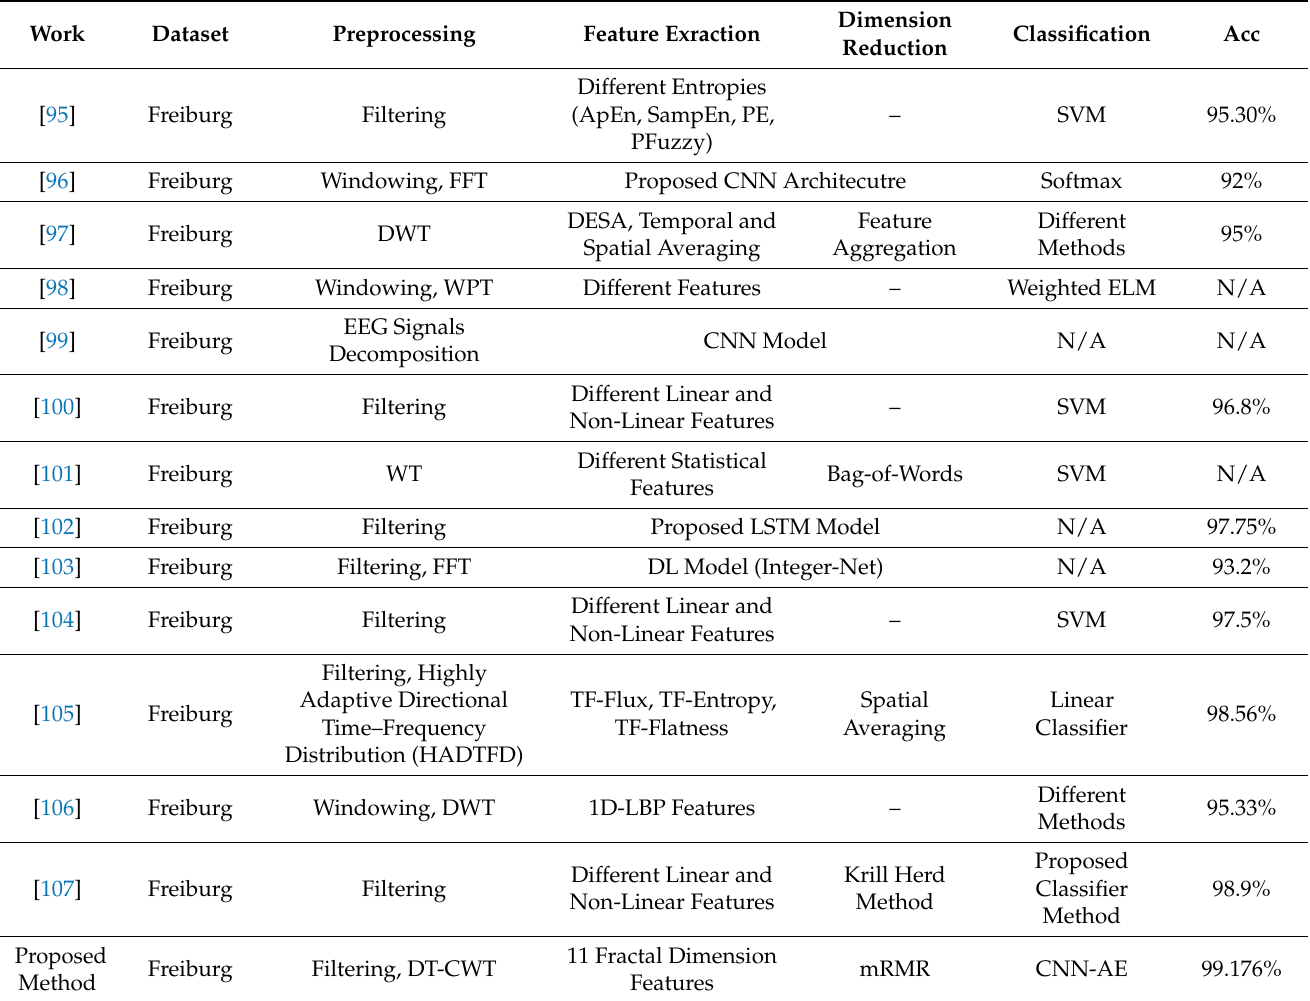
Table 11. Comparison of proposed method with other related works of the Freiburg